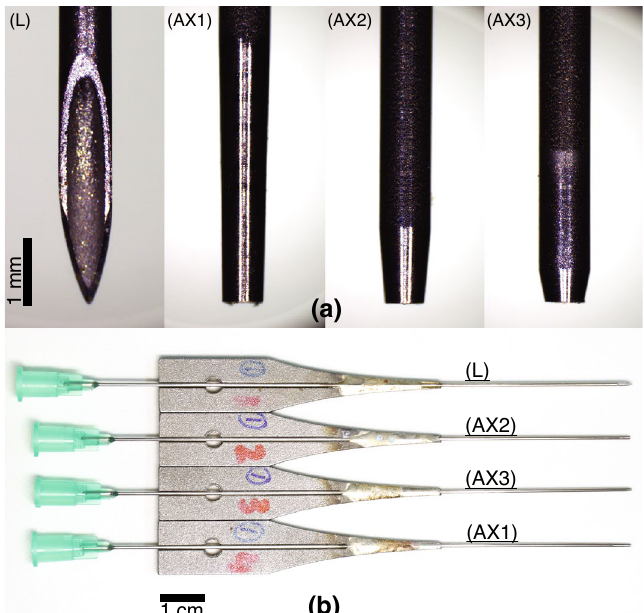
Figure 3. Characterisation was done for four needle tip types (photographed), a commercially-available lancet (L), and three fabricated axi-symmetric single-step bevels (AX1–3), with bevel lengths (BL) of 4, 1.2, and 0.5 mm, respectively. ( a ) a close-up side-view of the fabricated needle tips. ( b ) Top view of the four needles, soldered to a 3D-printed waveguide, which were then attached to a Langevin transducer via a M4